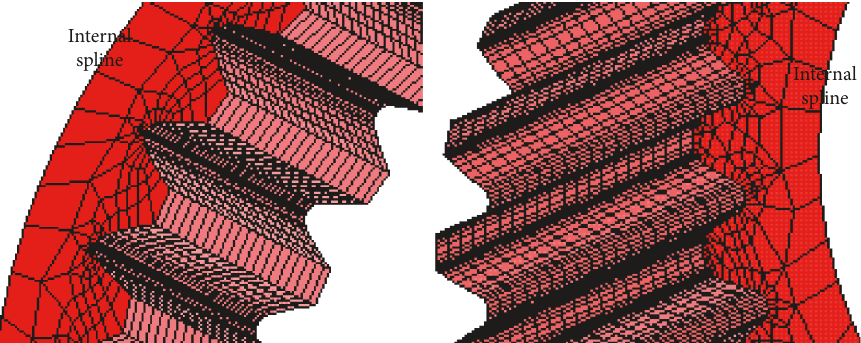
Figure 8: Finite element model of spline coupling.